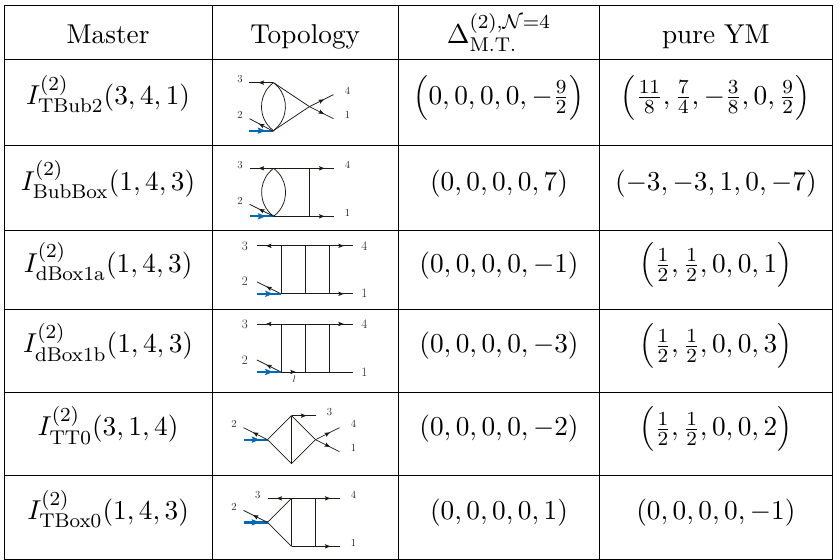
) means P c a B a . 1 , c 2 , c 3 , c 4 , c 5 a j i k l must involve a fermions loop, as indicated by M.T.